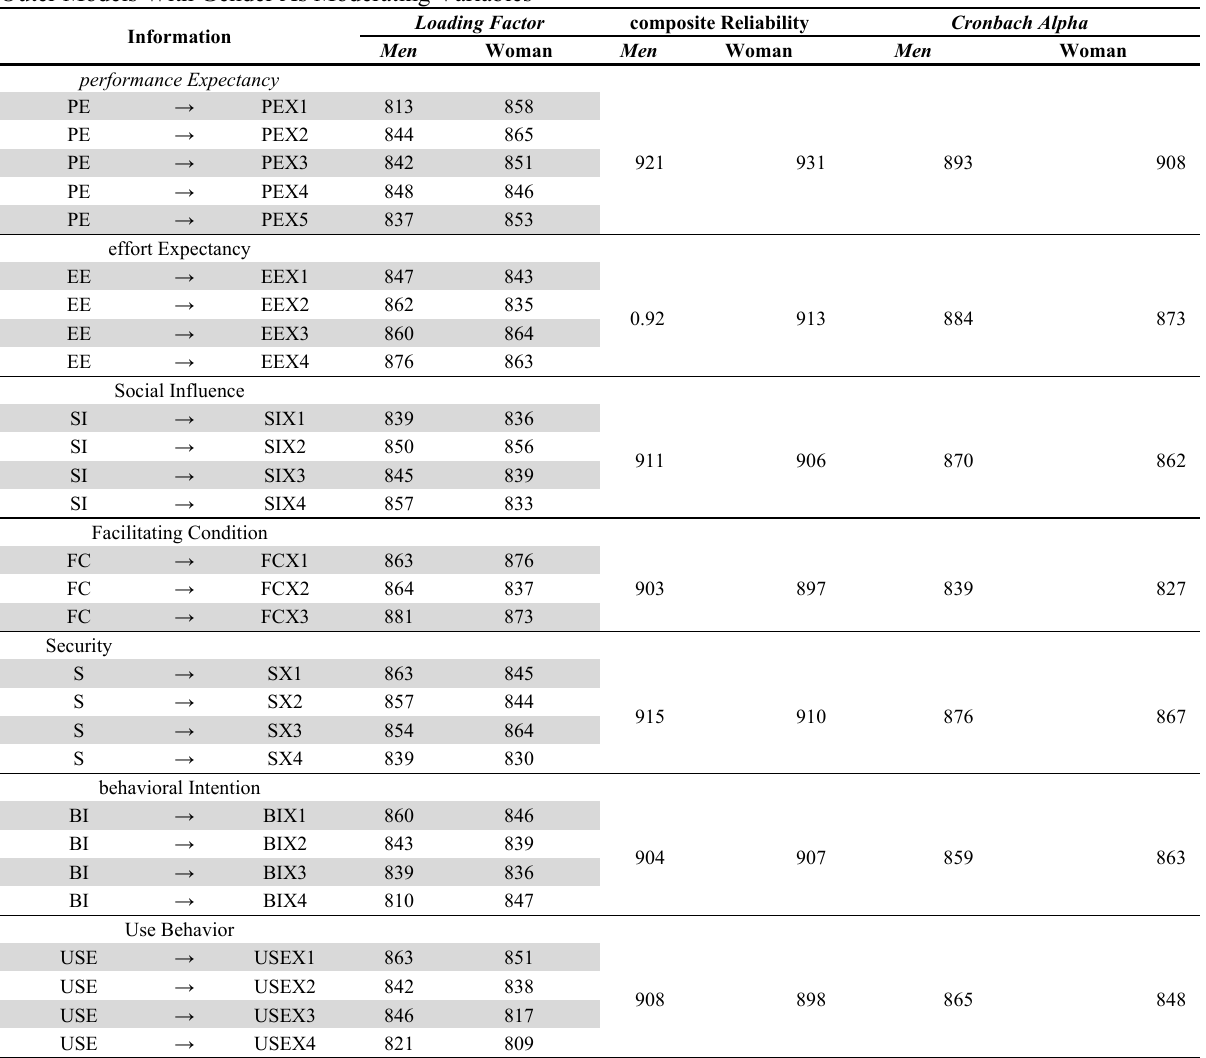
Outer Models With Gender As Moderating Variables